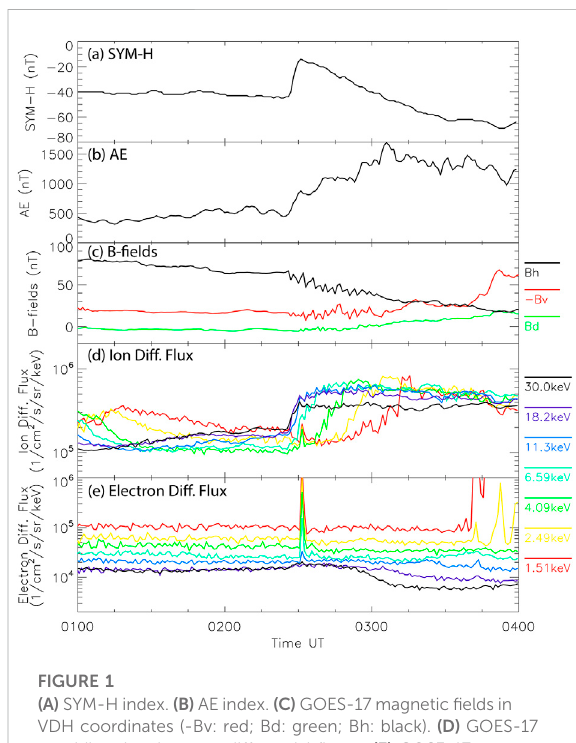
FIGURE 1 (A) SYM-H index. (B) AEindex. (C) GOES-17 magnetic fi elds in VDH coordinates (-Bv: red; Bd: green; Bh: black). (D) GOES-17 omnidirectional proton differential fl uxes. (E) GOSE-17 omnidirectional electron differential fl